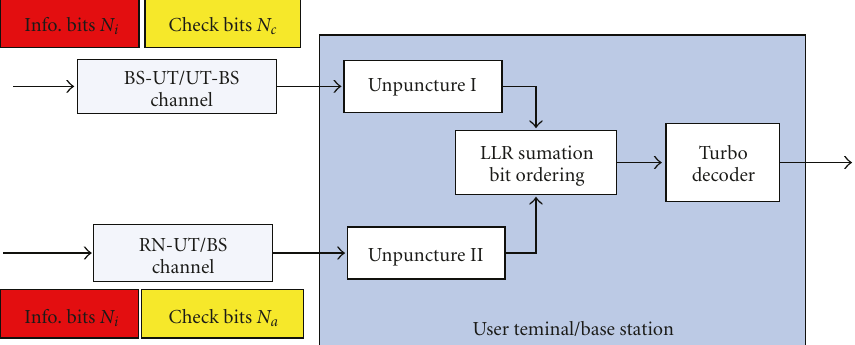
Figure 4: Hybrid-distributed turbo coding. Processing performed at